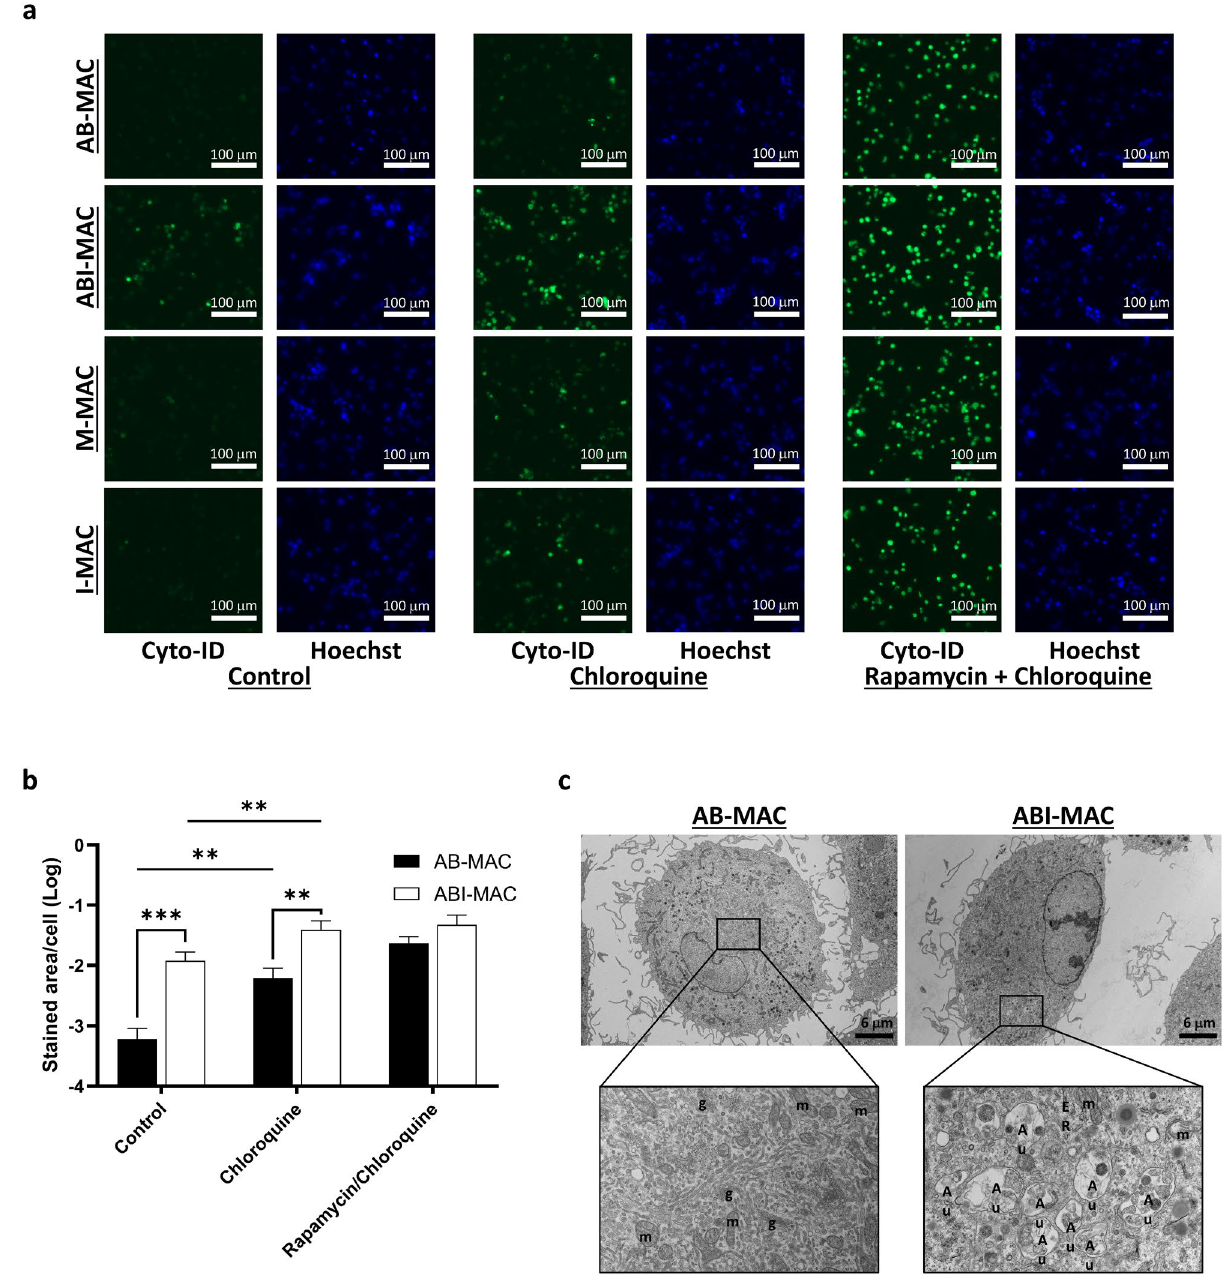
Figure 2. IL-27 induces autophagy in ABI-MAC. ( a ) AB-MAC, ABI-MAC, M-CSF-MAC and IL27 + M-CSF- MAC were incubated overnight in 96-well plate with or without treatment with either chloroquine (10 μM) or a combination of chloroquine and rapamycin (500 nM). Autophagosome staining was then performed using the Cyto-ID reagent, and Hoechst 33342 as a counterstain. 2 × 2 composite images were taken on a Zeiss AxioObserver motorized microscope at a ×10 magnification. ( b ) Autophagy induction in AB-MAC (closed bars) and ABI-MAC (opened bars) was measured. The average stained area per cell for each condition was calculated; values represent means and SD from five independent experiments. Results of significant and relevant Student’s t -test are indicated, **p < 0.01, and ***p < 0.001. ( c ) AB-MAC and ABI-MAC were seeded in 6-well plate (1.5 × 10 6 cells/well) and fixed overnight with 2% glutaraldehyde in cacodylate buffer before being processed and embedded in epoxy resin for TEM imaging as described in the Materials and Methods. Boxed ROIs were magnified for organelle analysis. g Golgi, m mitochondria, ER endoplasmic reticulum, Au